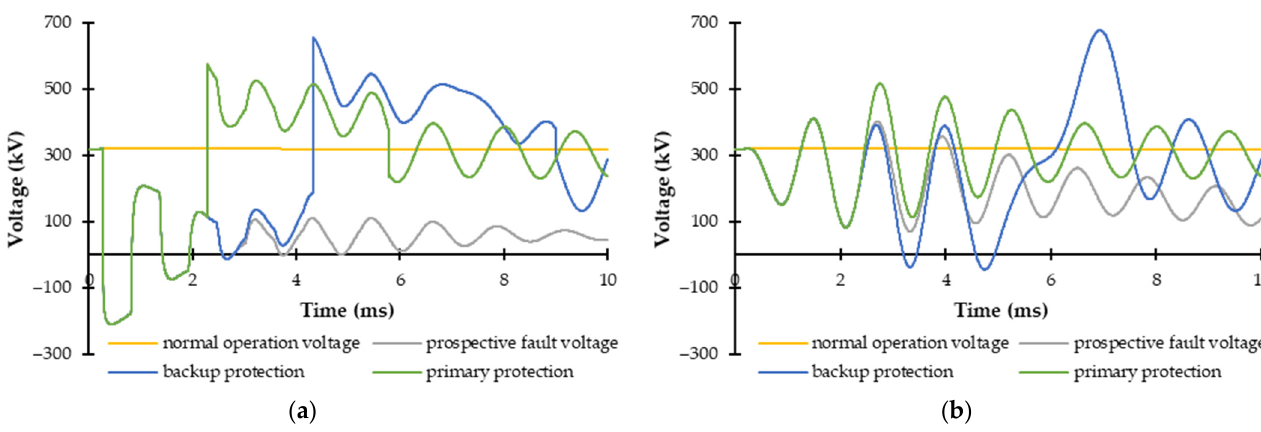
Figure 10. Comparison of ( a ) V L and ( b ) V B during primary and backup operation against a 0 Ω PtP fault located in link 14 at 150 km from